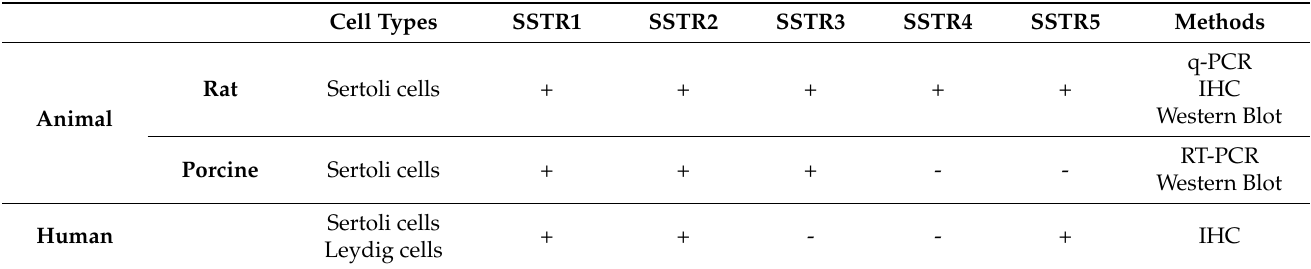
Table 1. Different SSTR subtypes of testicular expressions in humans and